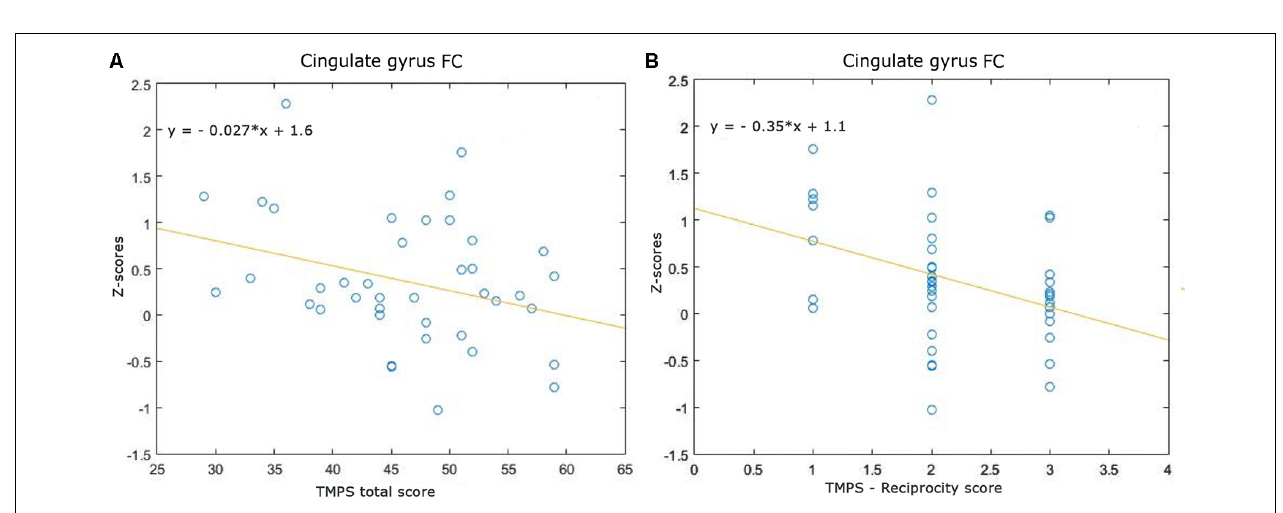
FIGURE 4 | Scatterplots of associations between resting-state functional connectivity (FC) of executive network abnormalities and social cognition tasks in MS patients. (A) Association between cingulate gyrus FC and TMPS; (B) association between cingulate gyrus FC and reciprocity score of TMPS.